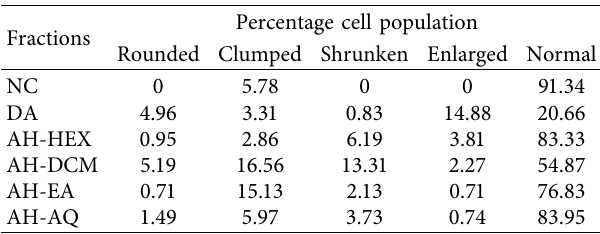
Figure 2: Effects of A. hispidum on cell morphology and nucleus-kinetoplast distribution of T . b . brucei. (a) Parasites were treated with fractions at the EC50 values and investigated using fluorescence microscopy. (b) Percentage cell population of parasites was calculated from an average count of 200 cells in 10 microscopic fields. AH-HEX � hexane fraction, AH-DCM � dichloromethane fraction, AH-EA � ethyl acetate fraction, AH-AQ � aqueous fraction, NC � negative control, MT � mito-tracker red CMXRos, DIC � differential interference contrast, white arrows ( N � nucleus, K � kinetoplast, M � mitochondrion, and F � flagellum of NC); green arrows � mitochondria of fractions, yellow arrows � cell morphology of fractions, and DA � diminazene aceturate (positive control). Table 2: Percentage cell distortion of T. b. brucei treated with A. hispidum